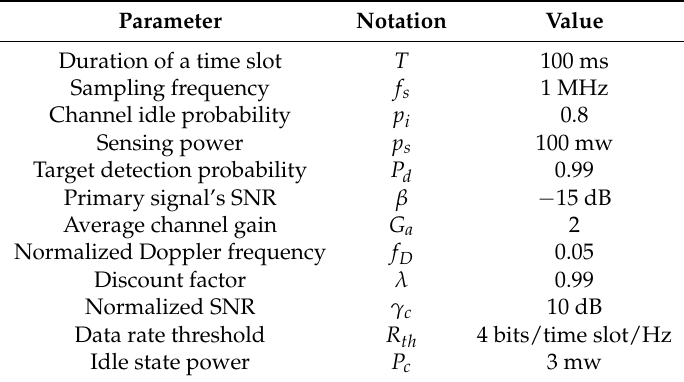
Table 1. Simulation